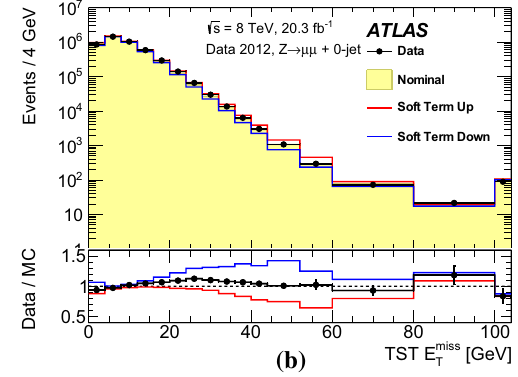
Fig. 26 Distributions of a E miss , soft and b E miss with the TST algo- and the insets at the bottom of the figures show the ratios of the data to T T rithm. Data are compared to the nominal simulation distribution as well the MC predictions. The uncertainties are estimated from the method as those resulting from applying the scale and resolution systematic in Sect. 8.2 uncertainties to the E miss , soft and adding the variations in quadrature, T